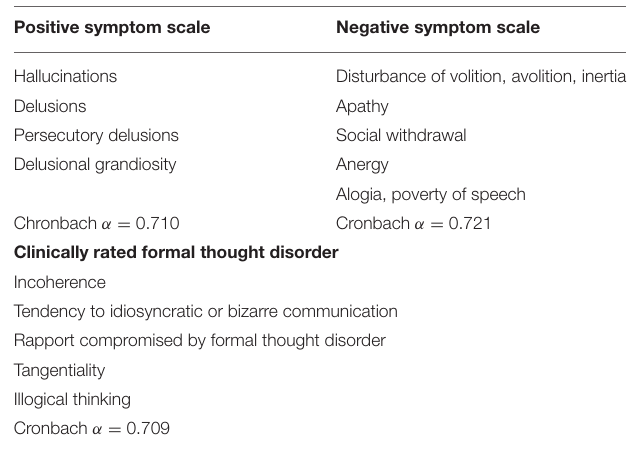
TABLE 1 | Psychopathological